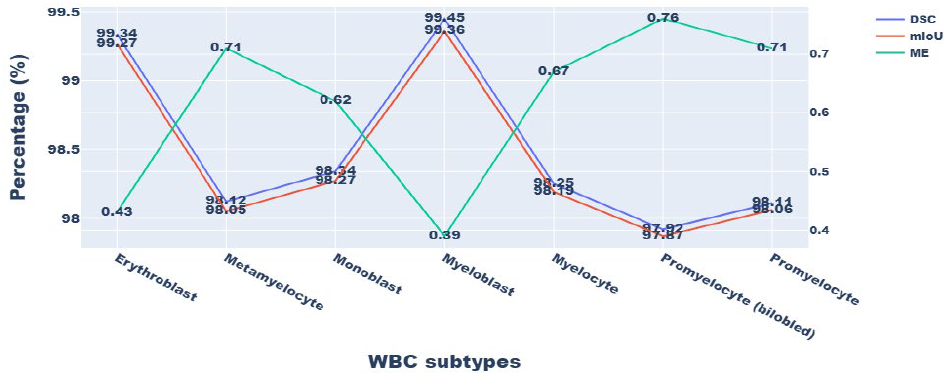
Figure 7. Segmentation results of various WBC subtypes on the single-cell morphology dataset. Segmenting myeloblasts is easier than segmenting promyelocytes (bilobed) because the dataset of promyeloblasts comprises only a tiny number of instances for promyelo- cytes (bilobed). The samples of this class are enlarged due to the suggested data augmen- tation technique, known as DCGAN, and improved results are obtained, such as 97.92% DSC, 97.87% mIoU, and 0.76% ME.